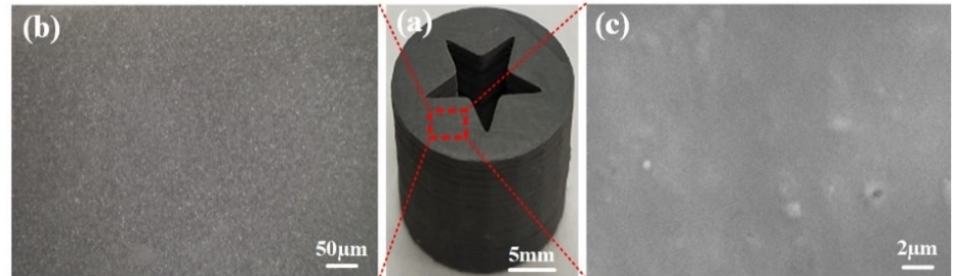
Figure 8. A 3D-printed energetic grain and its surface structure: ( a ) Printed grain; ( b ) Surface structure observed by optical microscope; ( c ) Surface structure observed by SEM.